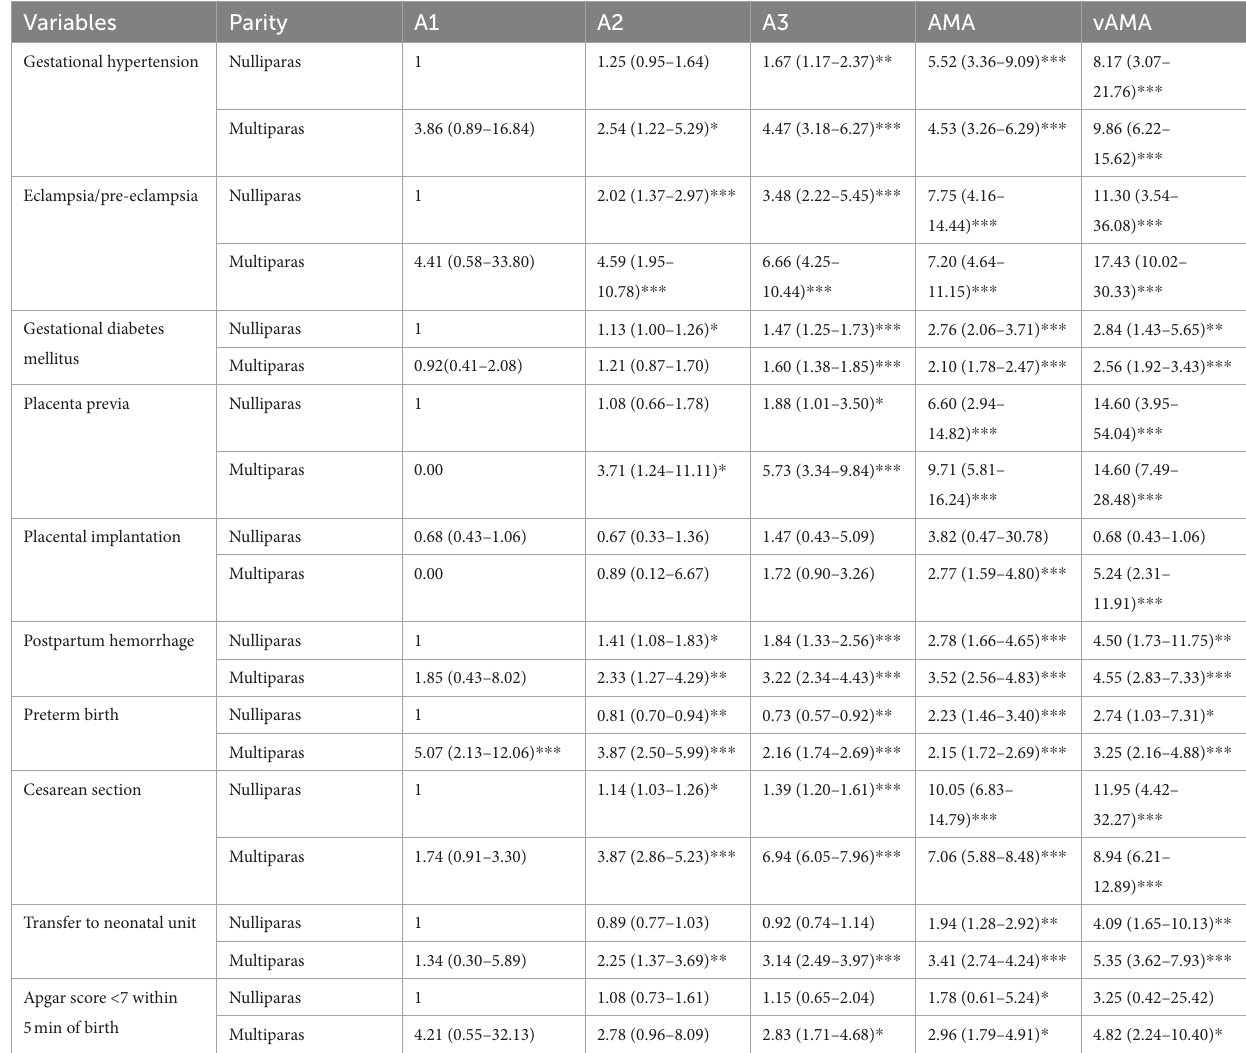
TABLE 5 Multivariable adjusted odds ratios ( aOR ) for adverse pregnancy outcomes and neonatal outcomes by group with different ages and parities.